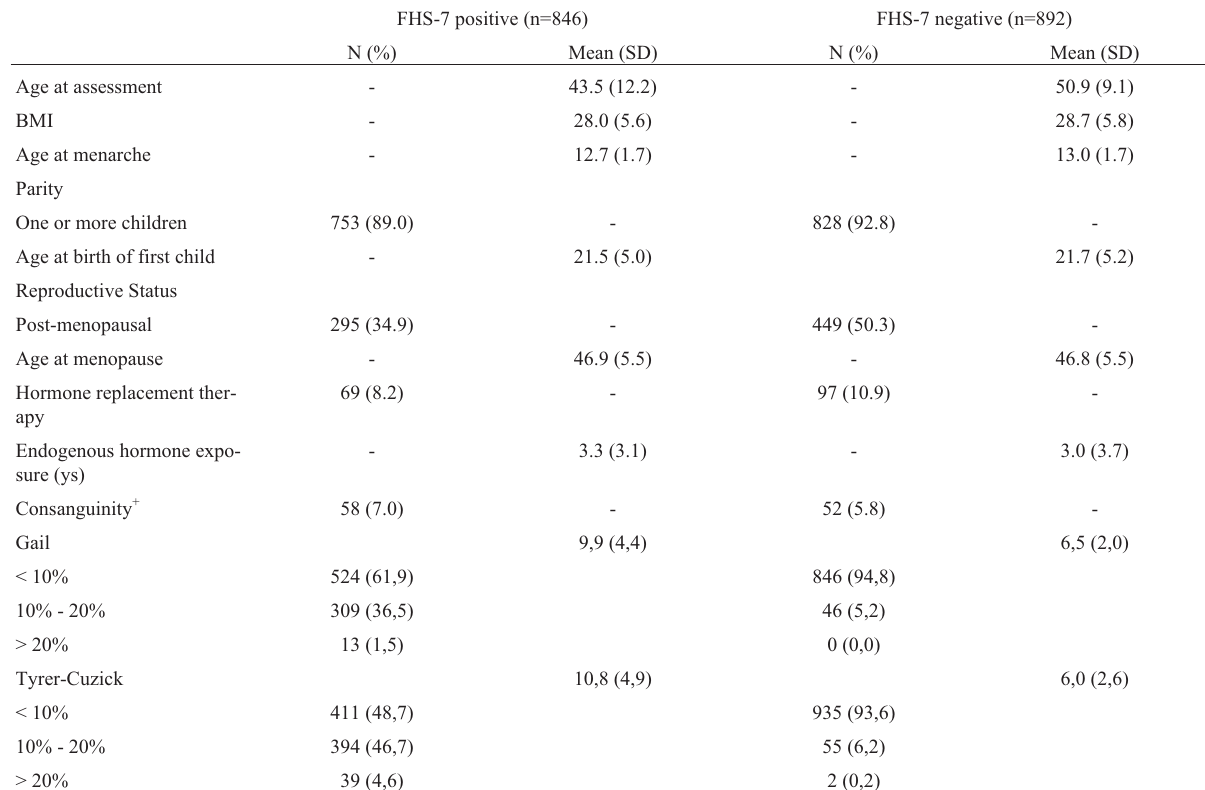
Table 1 - Descriptive data from demographics, reproductive and lifetime (up to age 80 years) breast cancer risk estimates variables in the FHS-7 positive and FHS-7 negative groups.